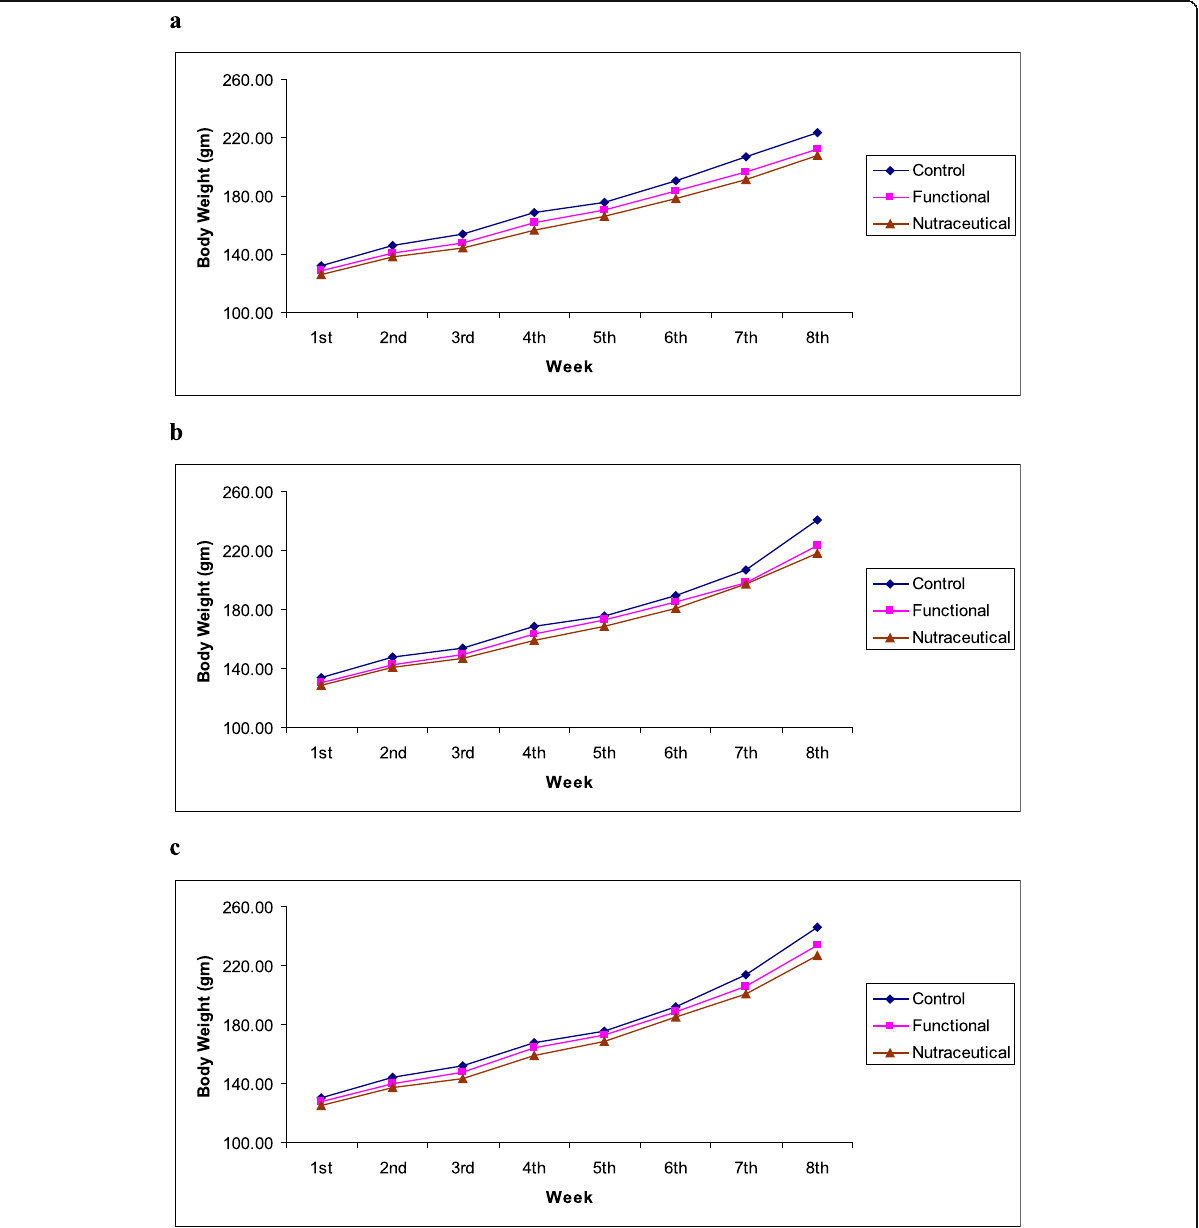
Fig. 3 Body weight of rats in different studies (g/rat) ( a ) Study I: Normal rats; ( b ) Study II: Hyperglycemic rats; and ( c ) Study III: Hypercholesterolemic